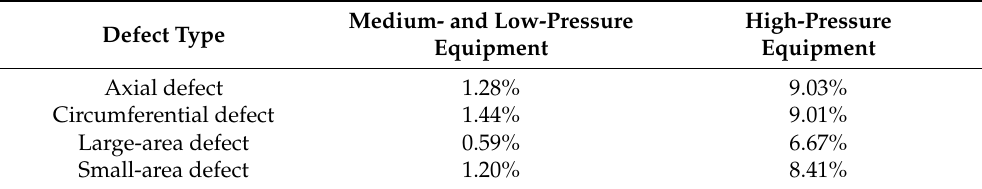
Table 10. The relative reduction in the average radius of the limit load curves of straight pipes with local wall-thinning defects under the influence of